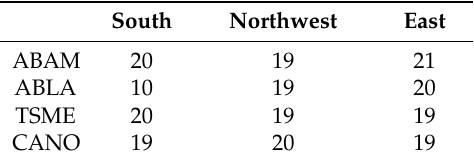
Table A1. Number of trees sampled from each species at each site included in analysis.